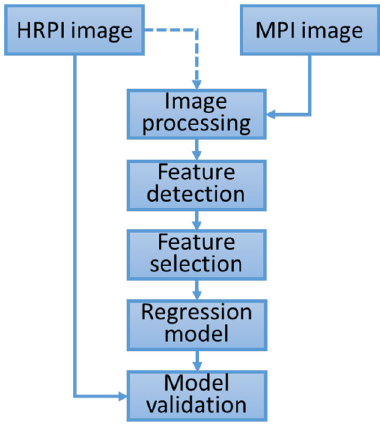
Fig. 5 Workflow diagram of image processing and statistical image analysis